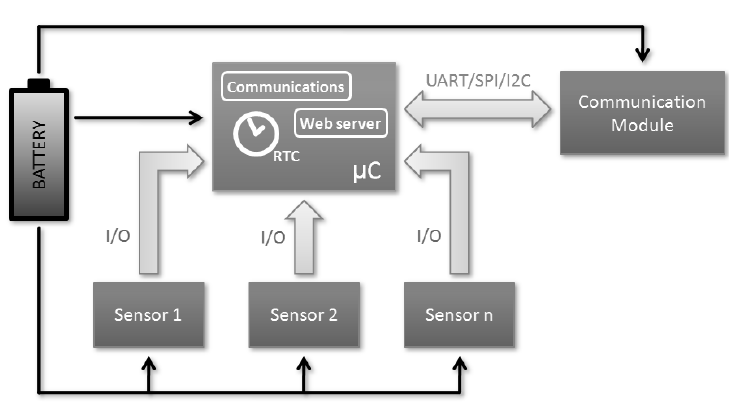
Figure 3. WebTag